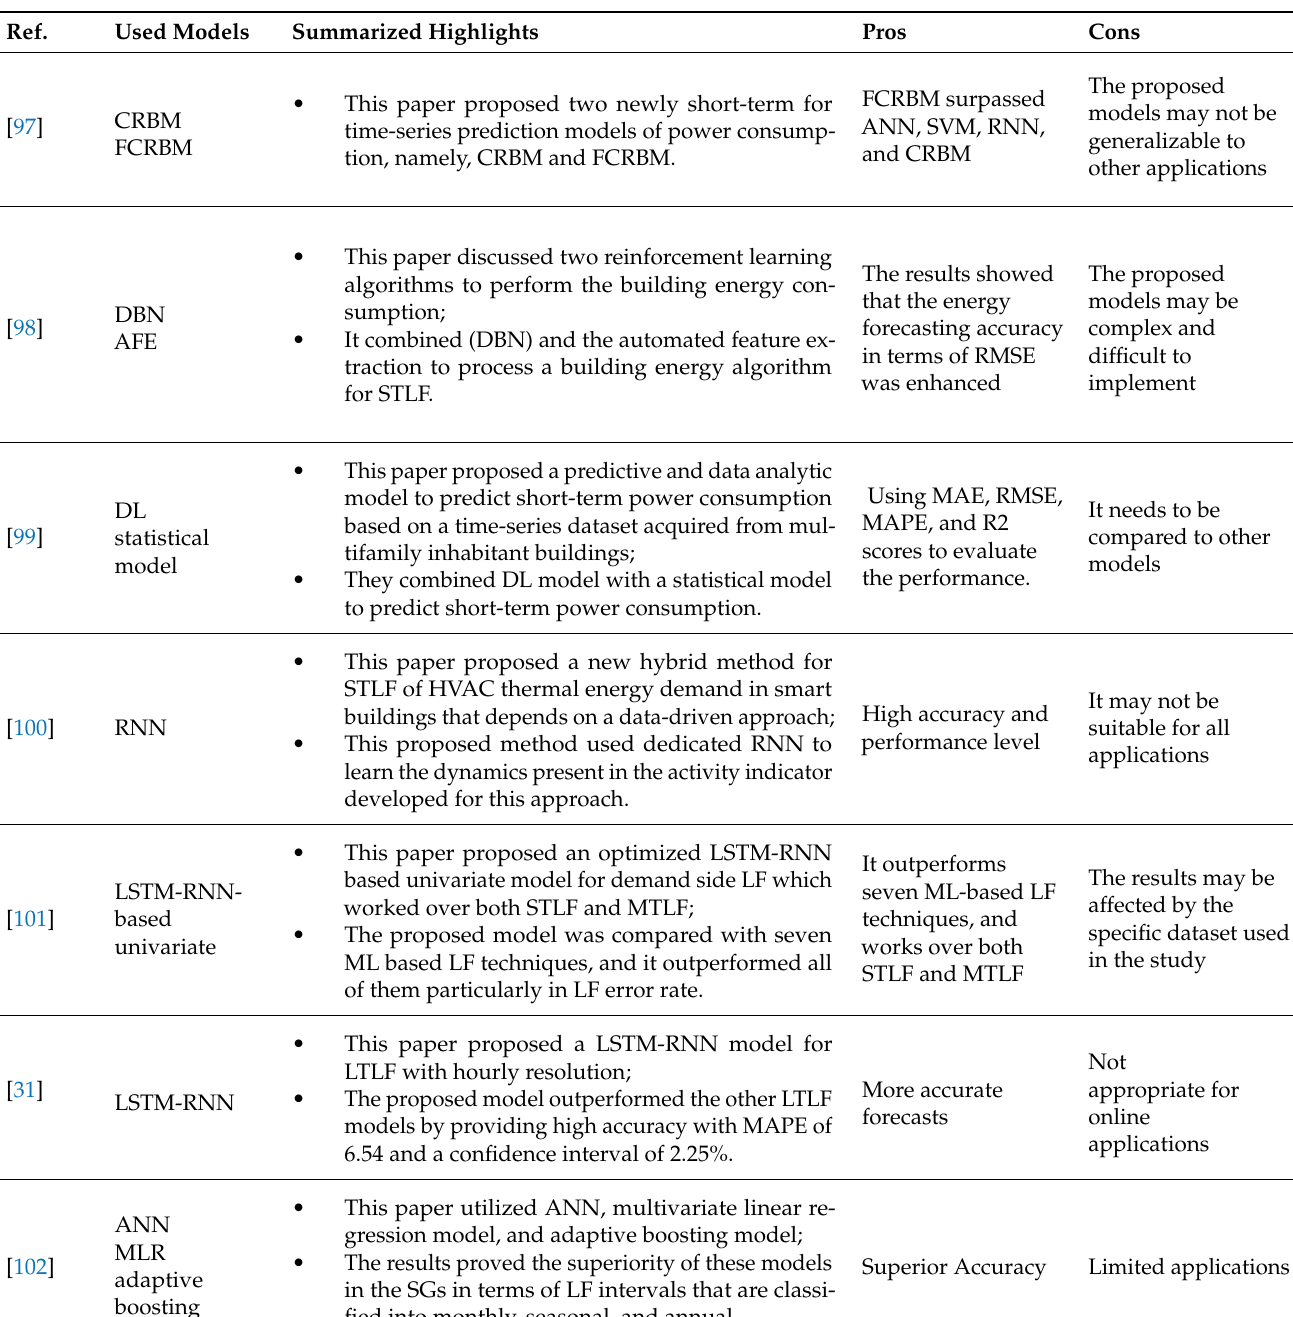
Table 5. Summary of time series load forecasting